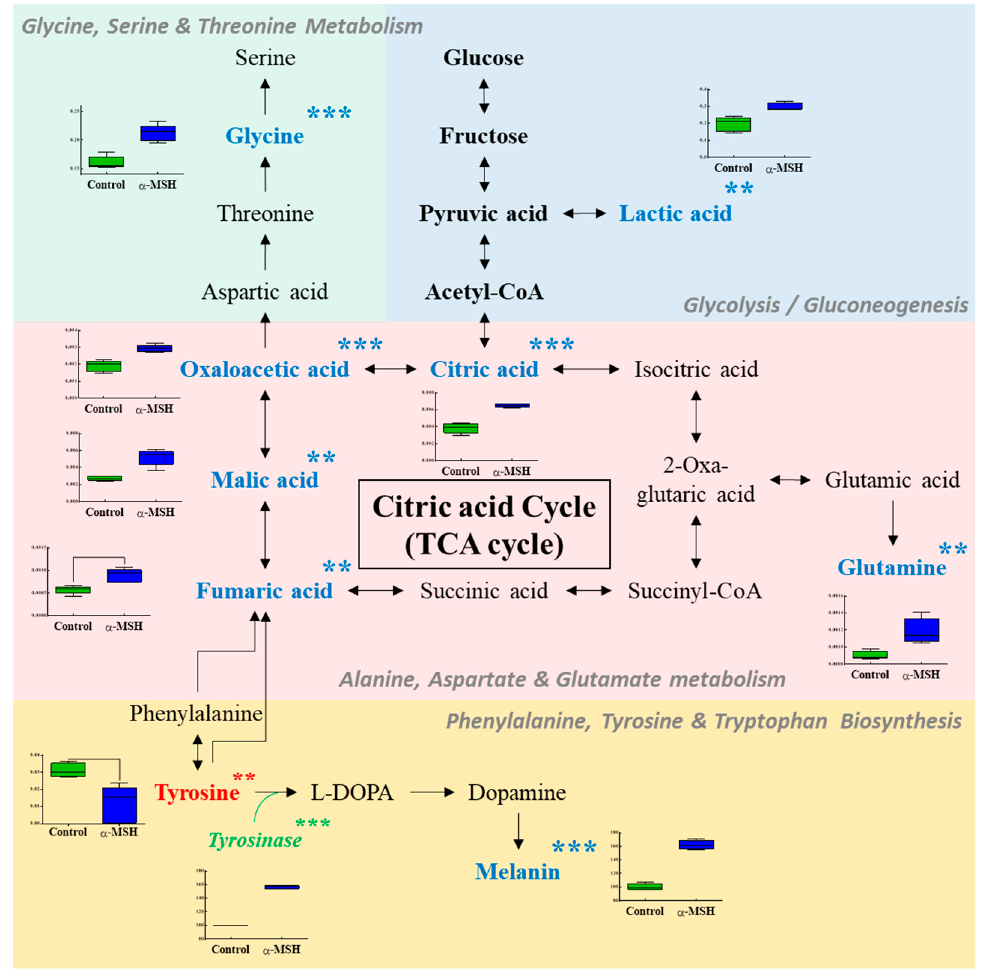
Figure 3. Schematic of the metabolic pathway related to the e ff ects of α -MSH. The metabolites in blue and red represent the potential biomarkers that are increased or decreased by α -MSH treatment, respectively. Symbols (*) indicate significant di ff erence (* p < 0.05; ** p < 0.01; *** p < 0.001). Table 2. Metabolic pathways a ff ected by α -MSH on B16F10 melanoma cell.